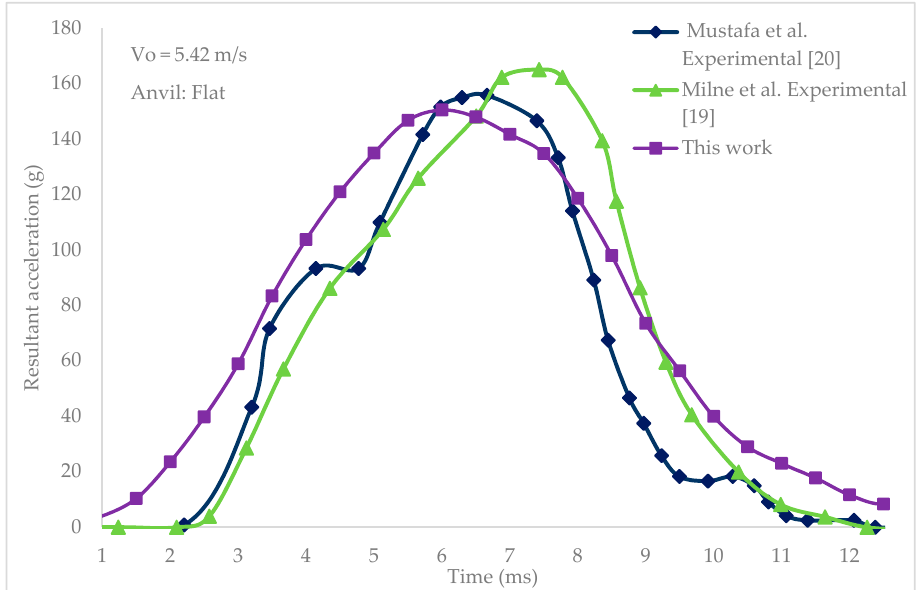
Figure 5. EN 1078 validation of flat anvil setup compared to previous research.